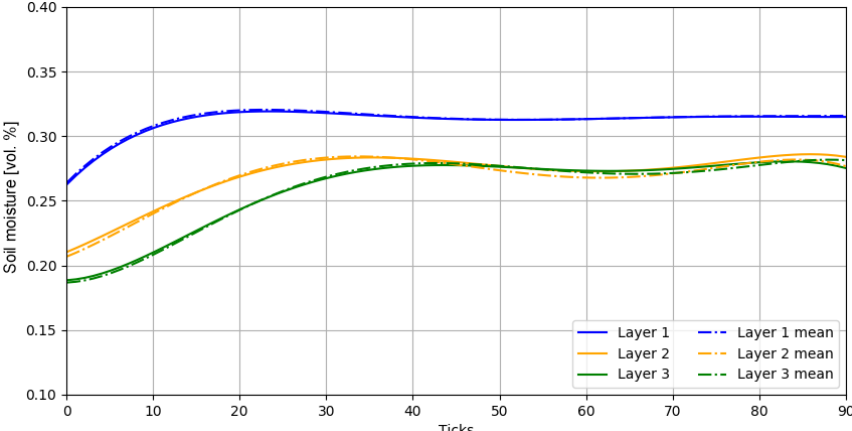
Figure 7. Mean resulting soil moisture after 20 runs to reduce effects of randomly chosen starting position.